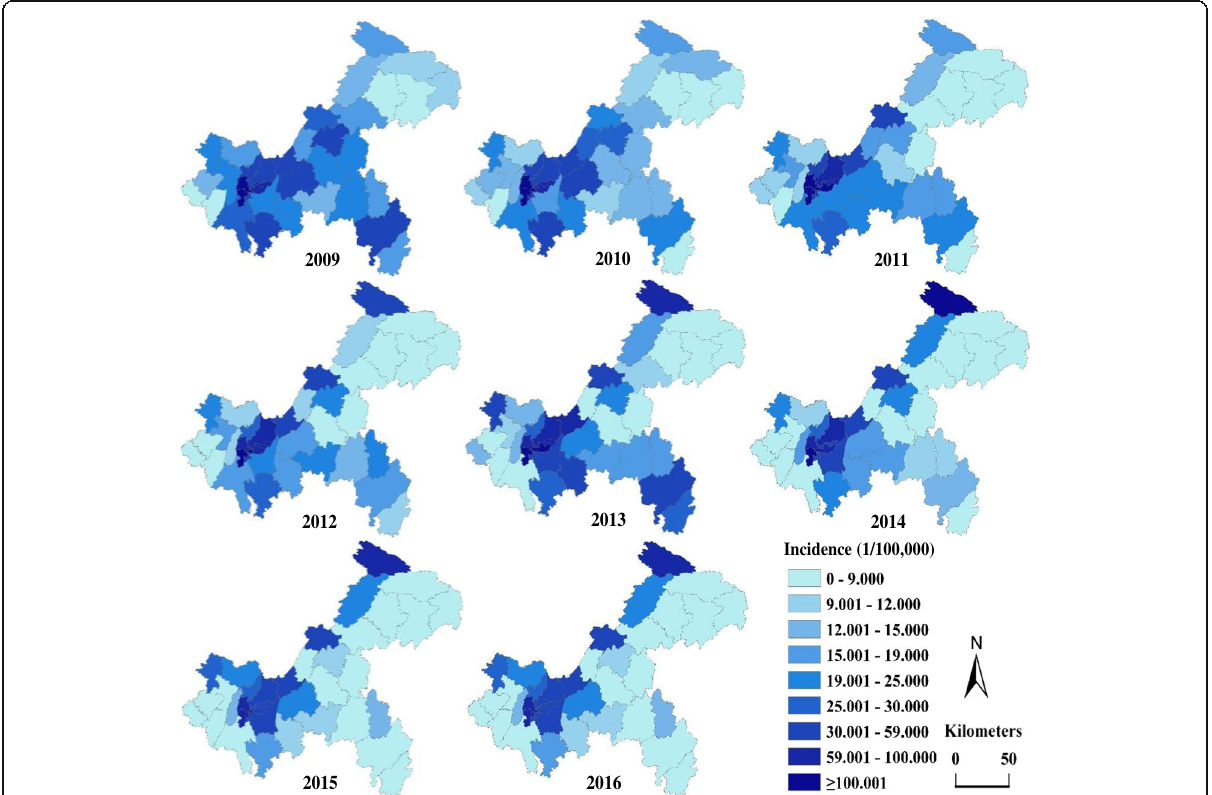
Fig. 5 Incidence maps of bacillary dysentery in Chongqing from 2009 to